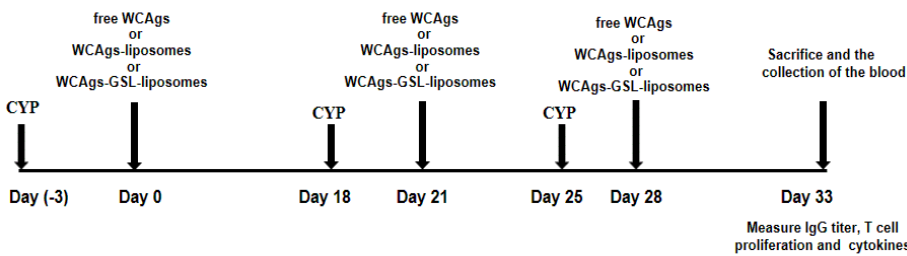
Figure 11. Schematic illustration of the immunization schedule in immunocompromised